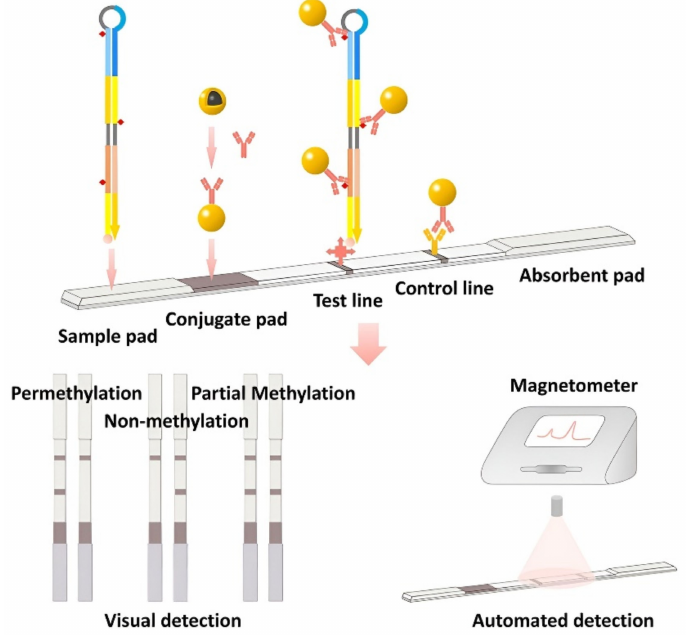
Figure 7. The schematic of DNA methylation biosensor by combination of isothermal amplification and lateral flow device. Reprinted from [80] with permission of Elsevier provided by Copyright Clearance